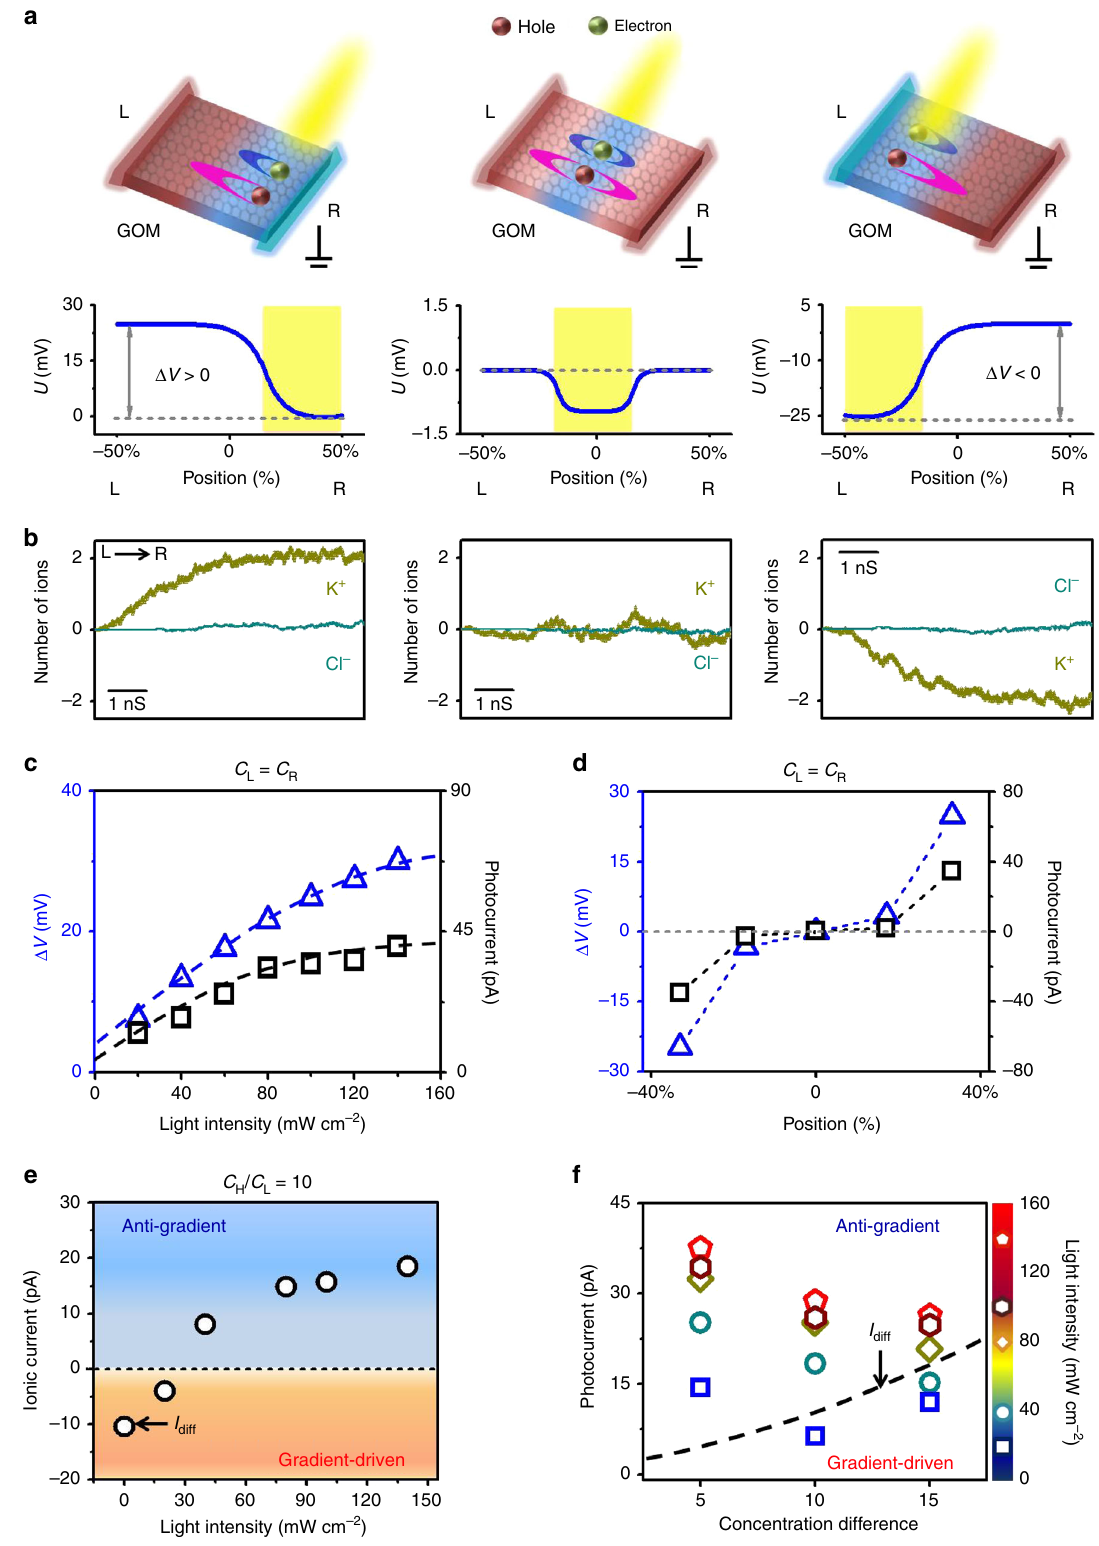
Fig. 3 Mechanism. a Asymmetric diffusion and electromigration of electrons and holes result in the redistribution of electric potential along the GO strip and local low electric potential in the illuminated area. When illumination was on an off-center position (left and right), an electric potential difference ( Δ V ) can be found. b MD simulations con fi rm the generation of horizontal cationic transport, depending on the illumination position. c , d The polarity and magnitude of Δ V and photocurrent depend on illumination position and light intensity. e Under 10-fold concentration gradient, photo-induced ion transport counterbalances diffusion current ( I diff ). Over a threshold light intensity, ionic current reverses to anti-gradient direction. f Similar trends were found under 5- to 15-fold concentration gradients. The threshold light intensity increases with the concentration gradient. The dashed line in ( f ) indicates I